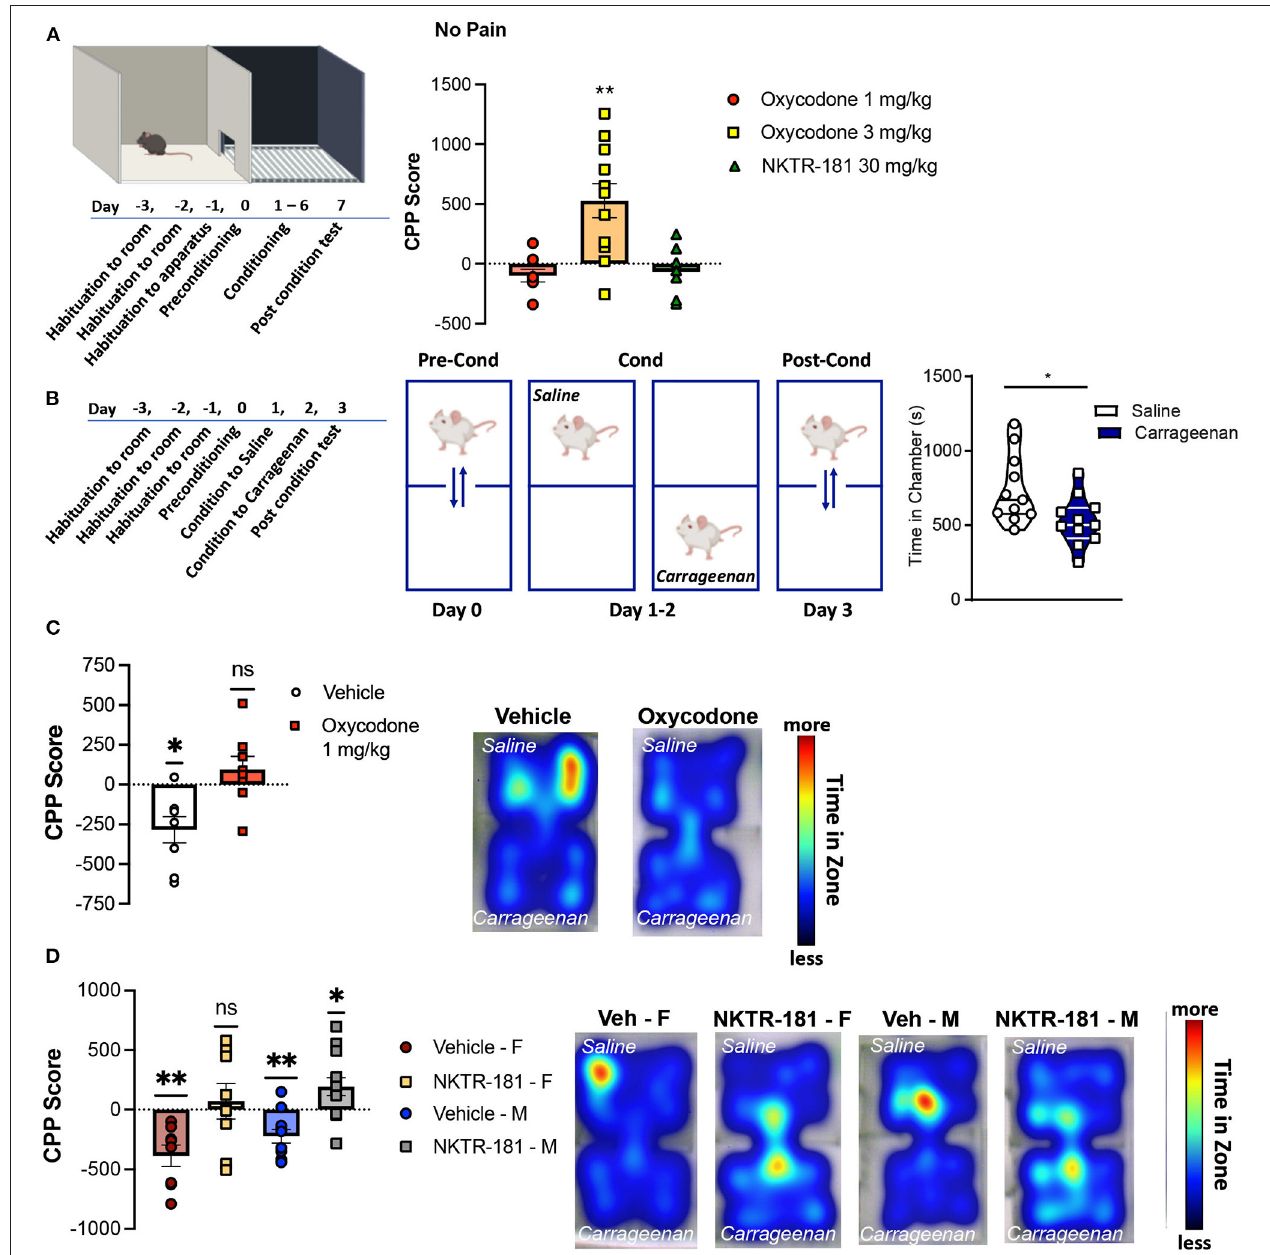
FIGURE 8 | Oxycodone and NKTR-181 block pain aversion at doses that have no effect on sensory thresholds. (A) Time course of conditioned place preference (CPP) paradigm for oxycodone (1 and 3 mg/kg, i.pl.) and NKTR-181 (30 mg/kg, i.pl.) in pain-naïve male mice. Conditioning was carried out once a day (drug or vehicle) for 6 days and post-conditioning was in a drug-free state. Only the higher dose of oxycodone produced a place preference. (B) Time course and paradigm for carrageenan-induced conditioned place aversion (CPA). Mice were conditioned to either i.pl. vehicle or carrageenan (2%) beginning 1h after injection. (C,D) Carrageenan-induced a place aversion in both male and female mice (left panels, * p 0.0119). (C) Oxycodone (1 mg/kg, i.pl., p 0.2785) blocked = = carrageenan-induced place aversion. Heat maps represent time in each conditioning zone. (D) The dose of NKTR-181 (30 mg/kg, i.pl.) that had no place preference in non-pain animals blocked carrageenan-induced place aversion. Heat maps represent time in each conditioning zone. All data are presented as CPP score. * p < 0.05,** p < 0.01. Refer to Supplementary Table 3 for statistics.